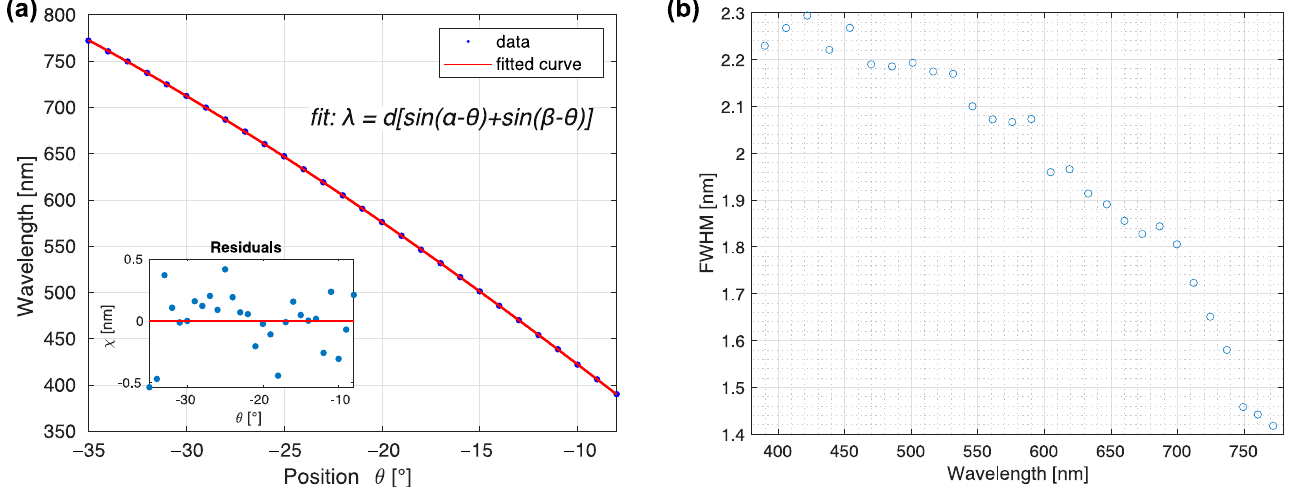
Figure 3. Monochromator angles and spectra. ( a ) Schematic of angles in monochromator equa- tions. Arrows indicate the direction of positive angles. ( b ) Spectra acquired with the spectrometer (normalized to 1).